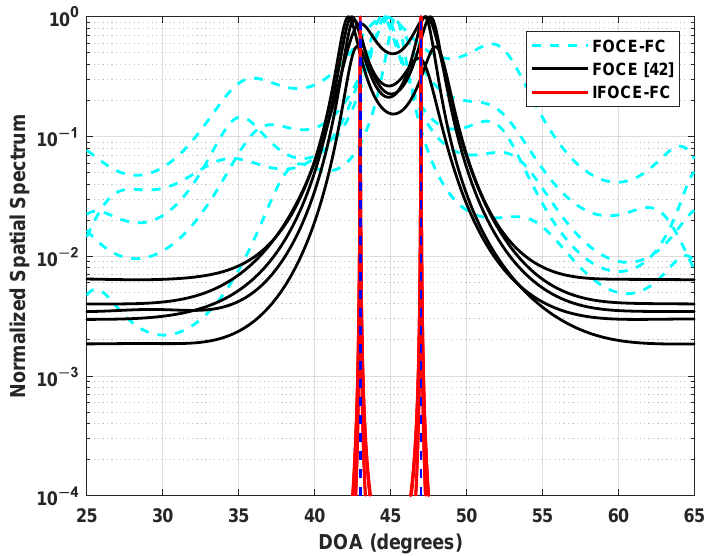
Figure 7. The normalized spatial spectrum for different DOA estimation algorithms in the ULA